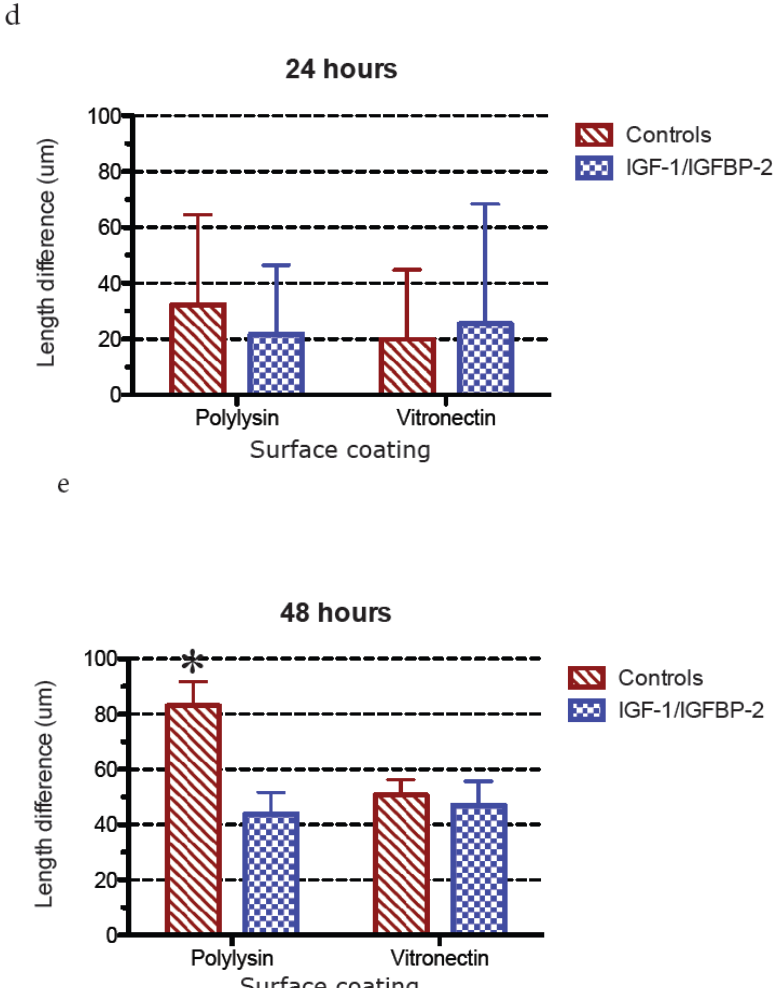
Figure 8. ( a )–( e ) The mean and standard deviation of the difference in length in micrometers between the longest neurite and the average length of three minor neurites are displayed. Six wells for each treatment and time point were used for measurements and five cells per well were measured. At later time points, there is trend towards poly-L-lysin without IGF-1/IGFBP-2 treatment being favorable for polarization. Also, at 48 h, growth on poly-L-lysin showed statistically significant differences (*) in micrometers between the longest and minor neurites compared to growth on vitronectin both with and without IGF-1/IGFBP-2 treatment (one-way ANOVA with Bonferroni post hoc test, p < 0.05).